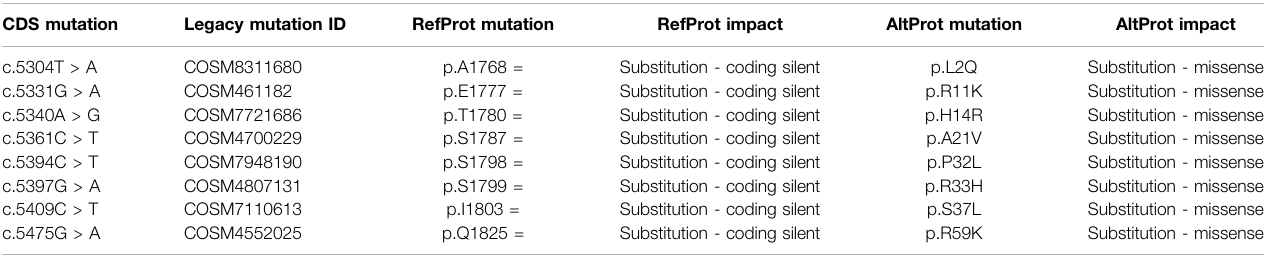
TABLE 2 | Identi fi cation of mutations based on the COSMIC database for the transcript: ENST00000360351.8 coding for MAP2 RefProt. These mutations are considering silent on the MAP2 RefProt but with an impact on the sequence of the resulting AltProts. CDS mutation